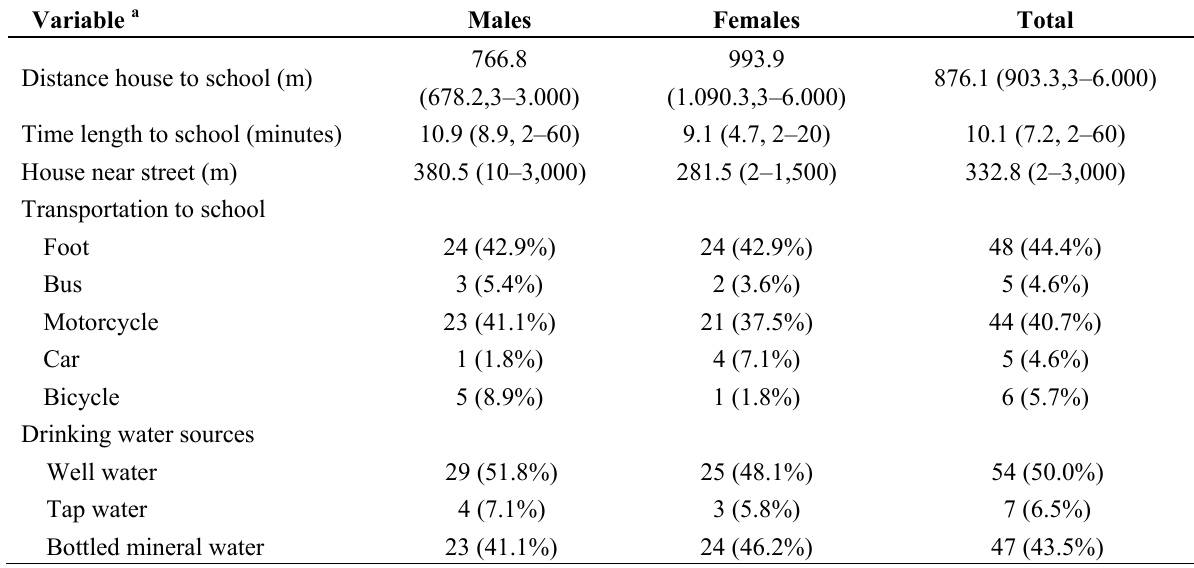
Table A3. Home environmental conditions of the study